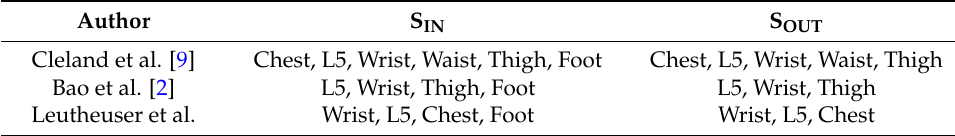
Table 4. Sensors used from ADAPT dataset to perform the performance on three PAC